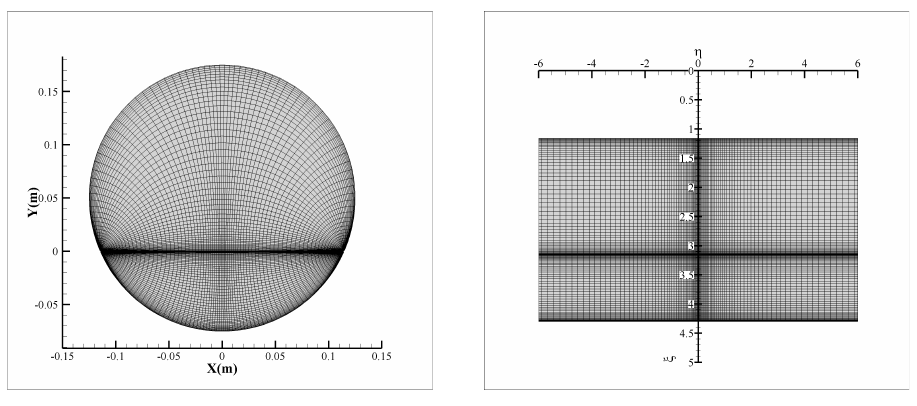
Figure 2. Schematic of the physical domain and bipolar coordinate system for pipe cross